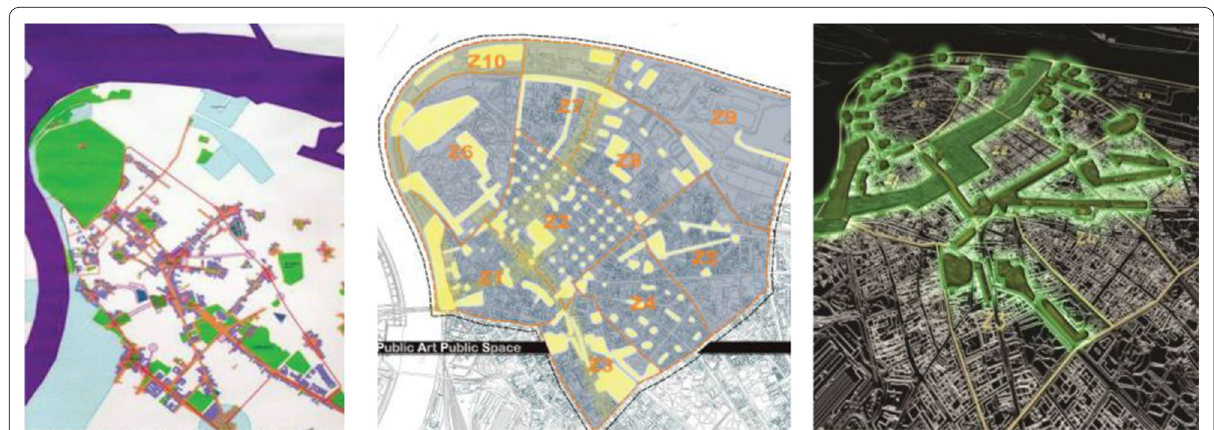
Fig. 5 Public art strategy for networking representative and marginal spaces. Case of Stari